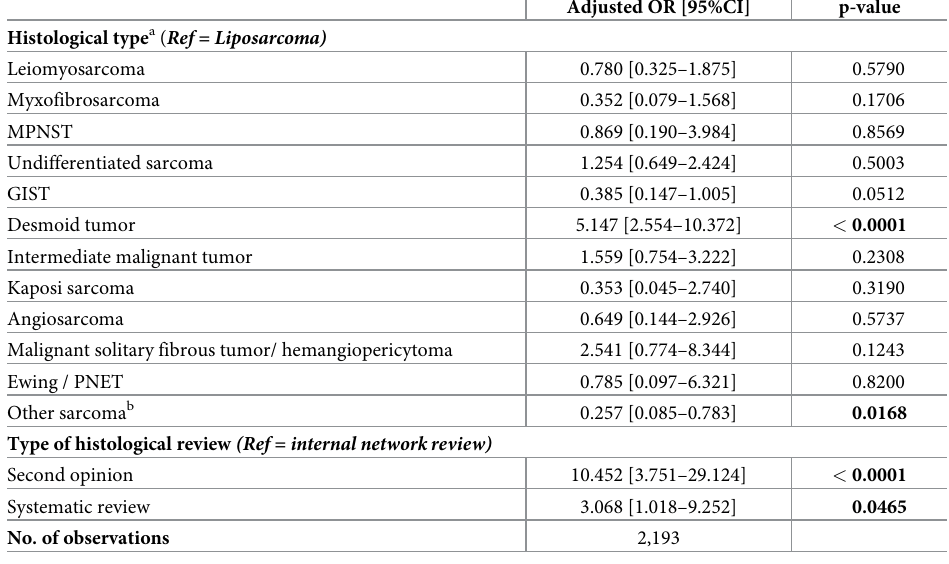
Table 5. Predictive factors of discordance with sarcoma, GIST, and desmoid tumors (results of the backward logistic regression